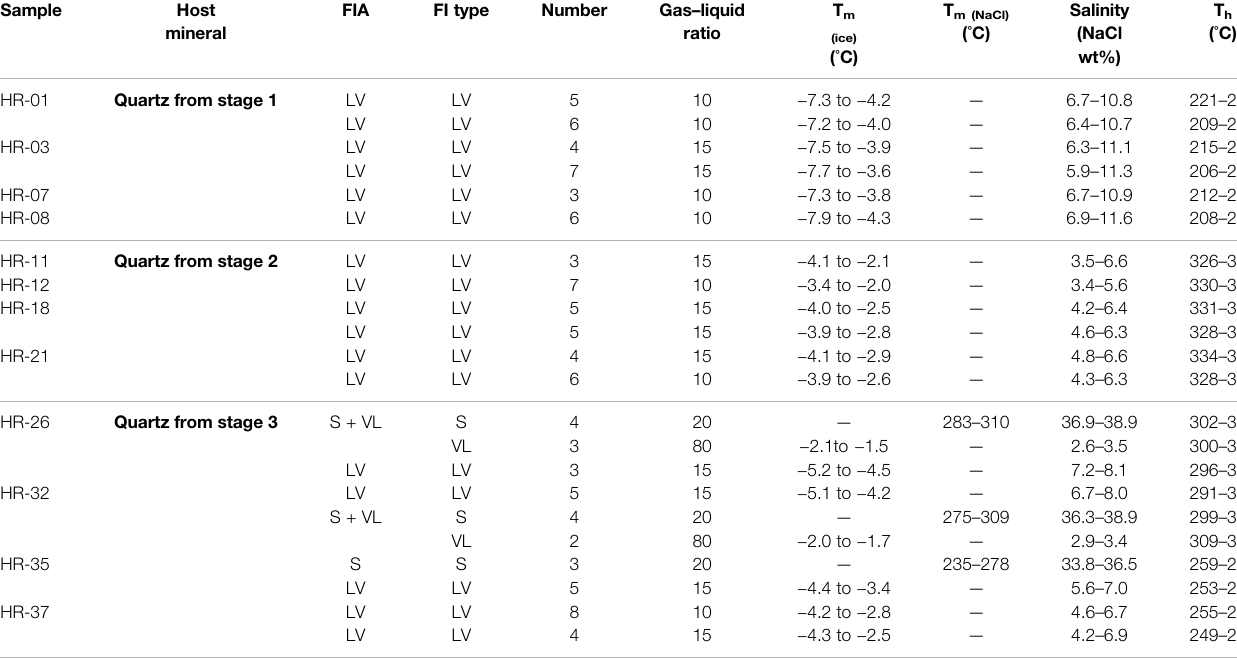
Quartz from stage 1